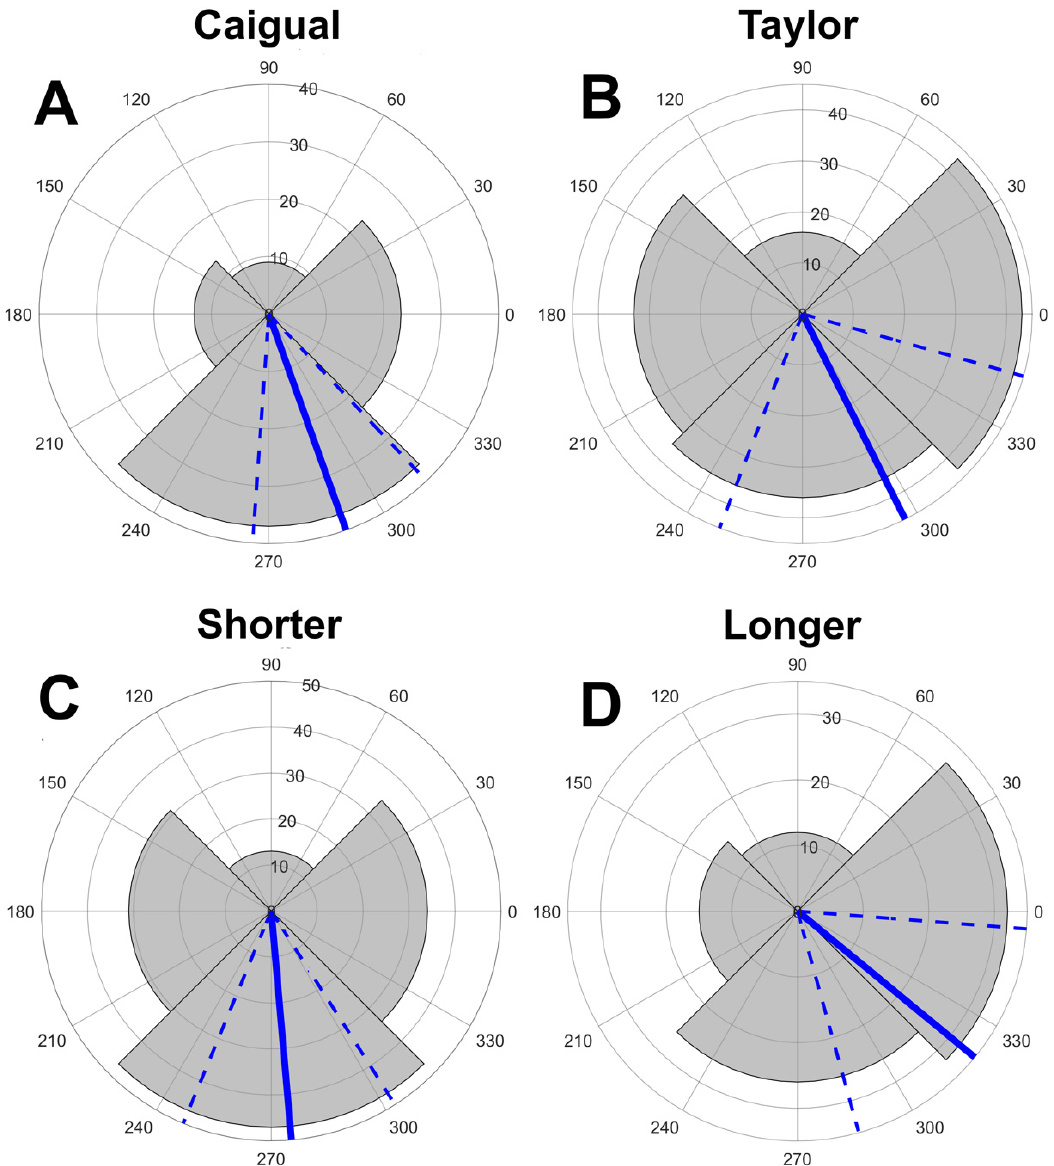
Figure 2. Distribution of direction records for the modal directions for each pair. Direction records for the two streams. Test results: ( A ): Caigual mn (mean vector) = 289.7°, s0 = 11.74, p = 0.0000, n = 82. ( B ) Taylor mn = 296.6°, s0 = 21.62, p = 0.0000, n = 128. Direction records for shorter ( ≤ 3 ) and longer (> 3) courtship sequences for both streams: ( C ): Shorter display sequences mn = 275.0°, s0 = 13.53, p = 0.0000, n = 125. ( D ) Longer sequences mn = 320.5°, s0 = 16.79, p = 0.0000, n = 85.